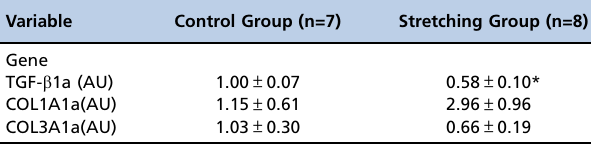
Table 2 - Acute effects of stretching on gene expression levels. Variable Control Group